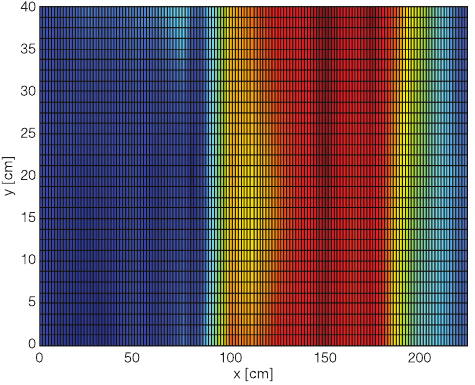
Fig. 9. Planar horizontal image of the metal sheet at 50 cm of depth corresponding to the return time of 15